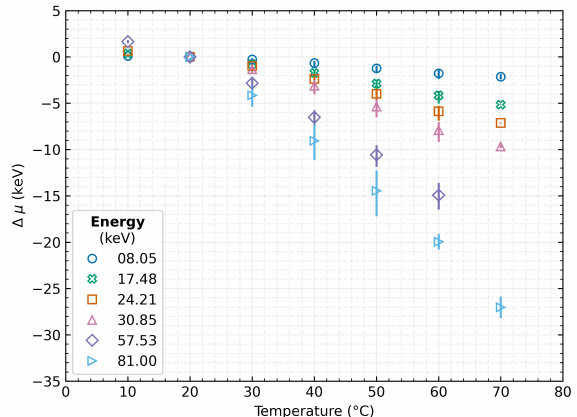
Figure 5. Absolute shift of the spectral peak for a given energy with respect to the detector’s temperature. The data represent the mean values over the tested detectors, and the error bars indicate their minimum and maximum